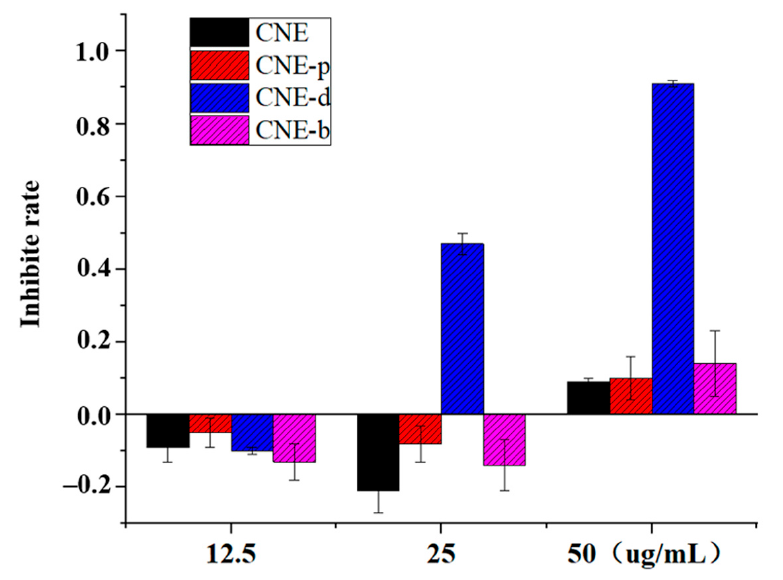
Figure 1. Cytotoxic effects of extracts obtained from C. nudiflora on RAW264.7 cells.